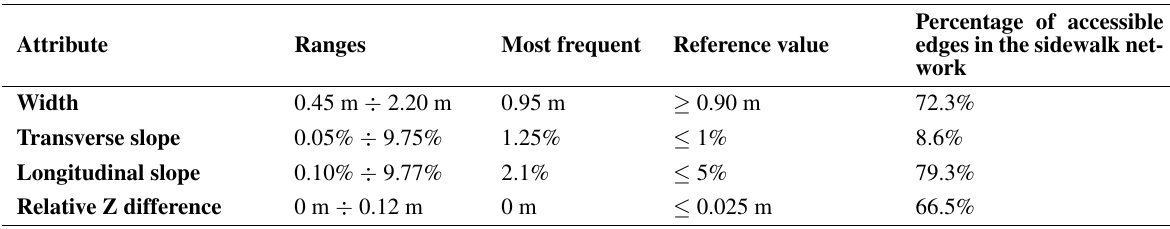
Table 1. Results of the sidewalk attribute extraction. The table shows the ranges of values of the attributes together with the most